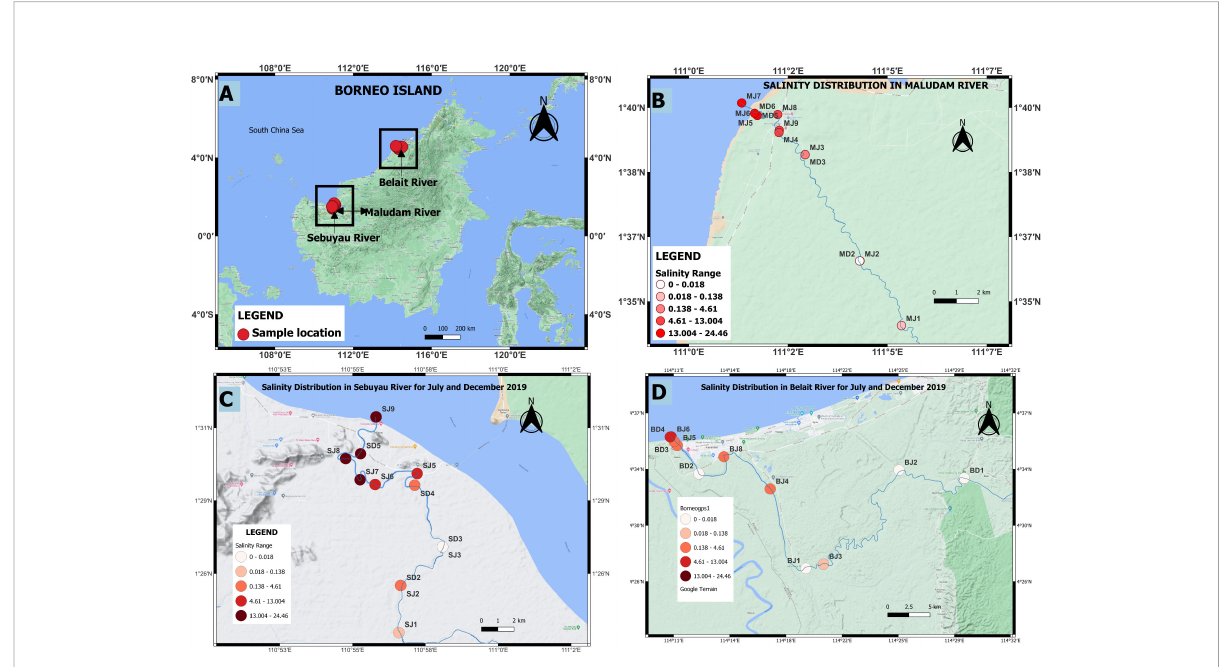
FIGURE 1 Distribution of sampling stations and salinity in the study area (A) Borneo Island (B) Maludam river (C) Sebuyau river (D) Belait river in July and December, 2019. MJ, Maludam July; MD, Maludam December; SJ, Sebuyau July; SD, Sebuyau December; BJ, Belait July and BD, Belait